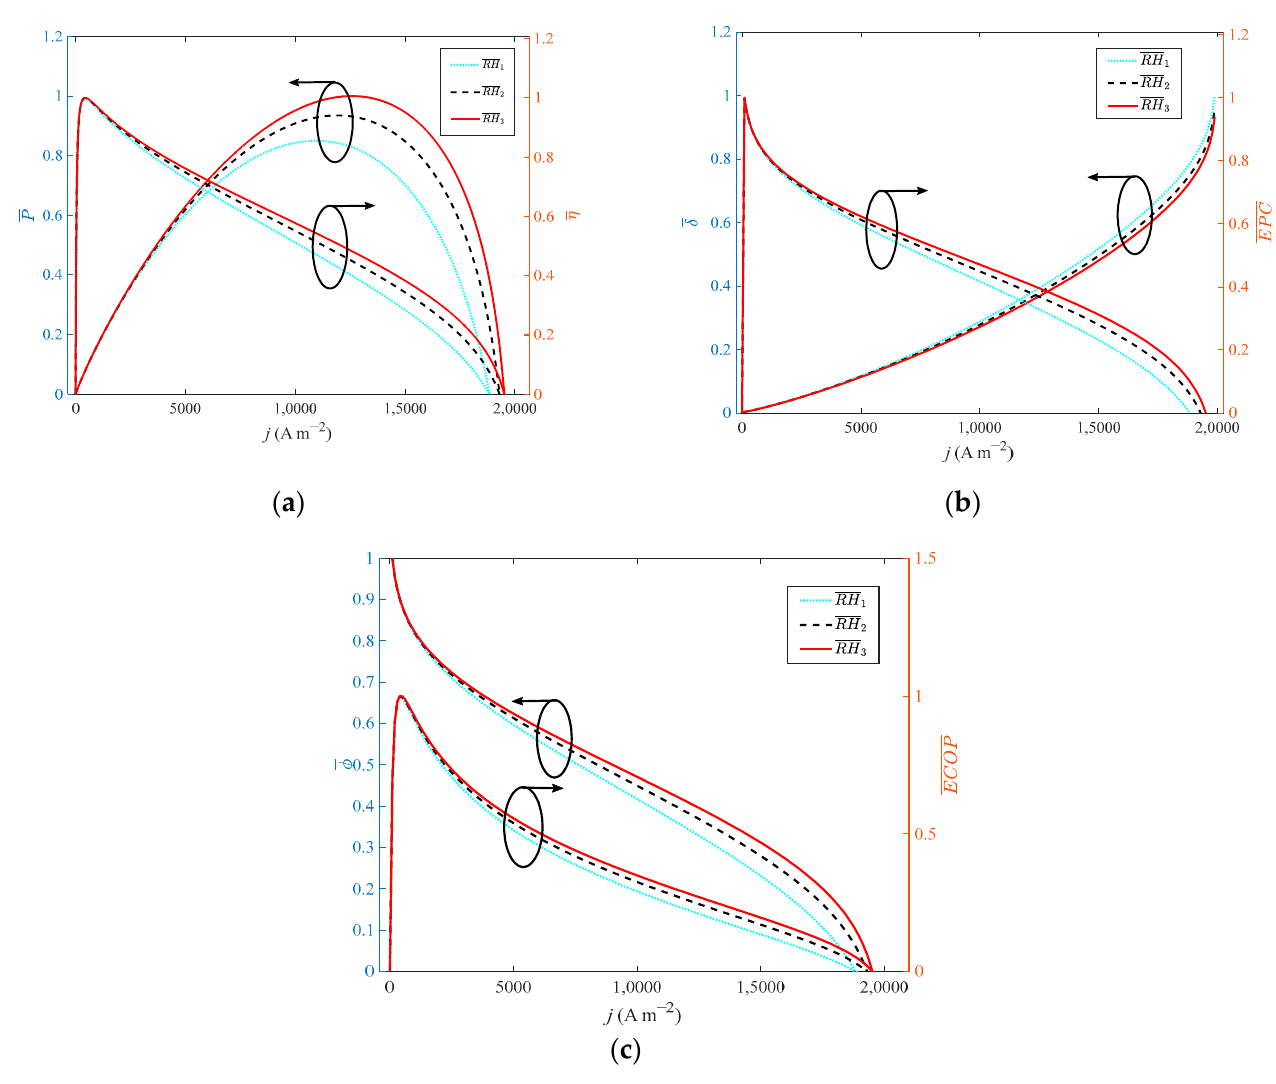
Figure 5. Different indexes vary with current density at different relative humidity: ( a ) P and η ; ( b ) δ and EPC ; ( c ) φ and ECOP .